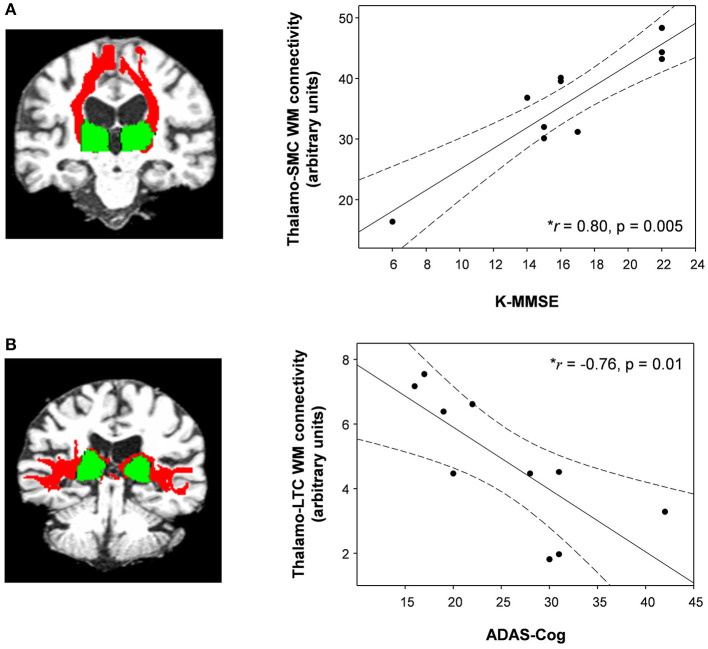
(A) The thalamo-sensorimotor cortex (SMC) white matter connectivity in patients with MCI was positively correlated with K-MMSE scores (Spearman's rho = 0.80, p = 0.005) and (B) the thalamo-lateral temporal cortex (LTC) was negatively correlated with ADAS-cog scores (Spearman's rho = −0.76, p = 0.01). Dotted lines show 95% confidence intervals. Red, white matter connectivity; green, thalamus ROIs (seed regions). • Shows WM connectivity and K-MMSE or ADAS-Cog in patients with MCI.